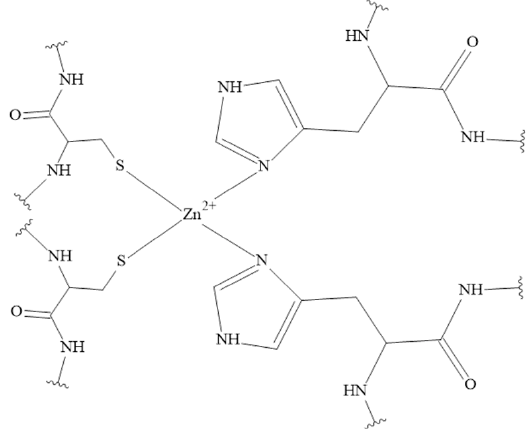
Figure 6. Cys 2 His 2 type of Zinc Finger Domain in Zn(II) complexes [150].